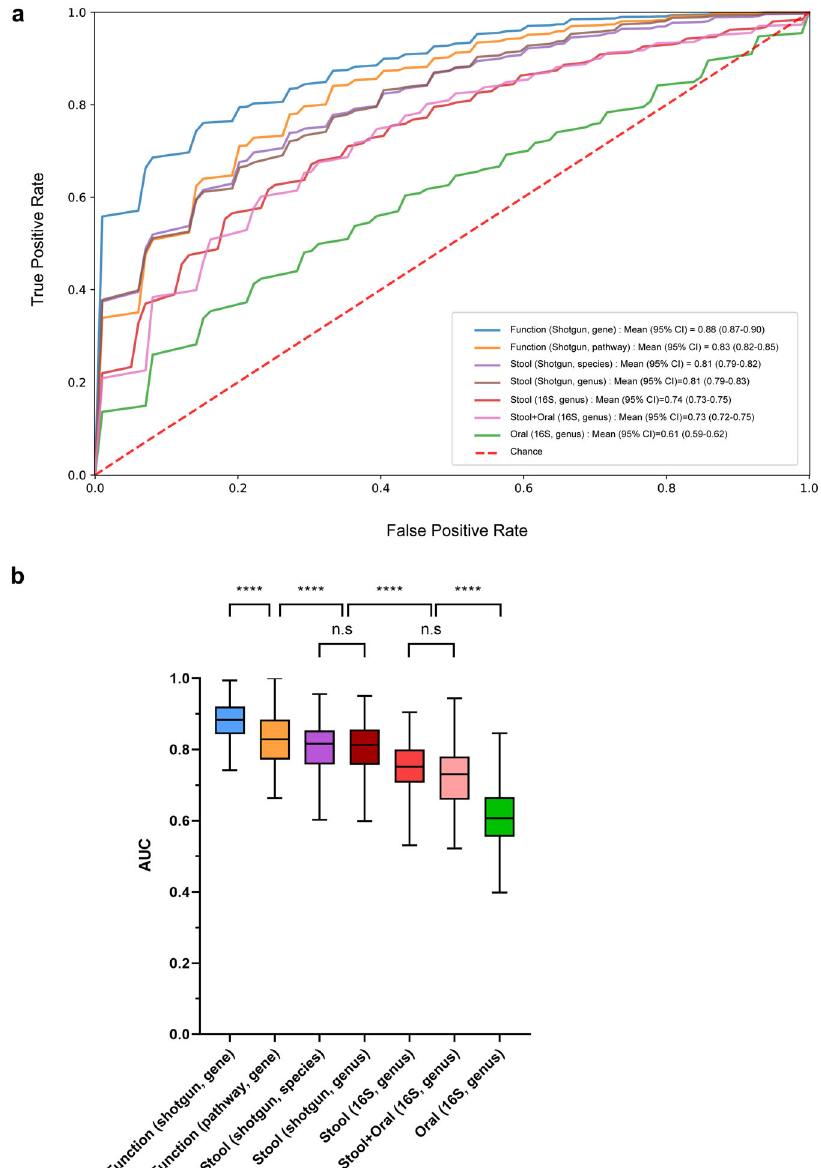
Fig. 6 Discriminating Parkinson ’ s disease from healthy controls based on the oral and gut microbiome. a Receiver operating characteristic curve of random forest classi fi er using shotgun or 16 S rRNA gene sequencing. b Comparison of each classi fi er. Boxplot centerline represents the median (50th percentile). The top and bottom hinges represent 75th and 25th percentiles, respectively. The upper and lower whiskers correspond to the highest and lowest data points. n.s: not signi fi cant, * P < 0.05, ** P < 0.01, *** P < 0.001, **** P <